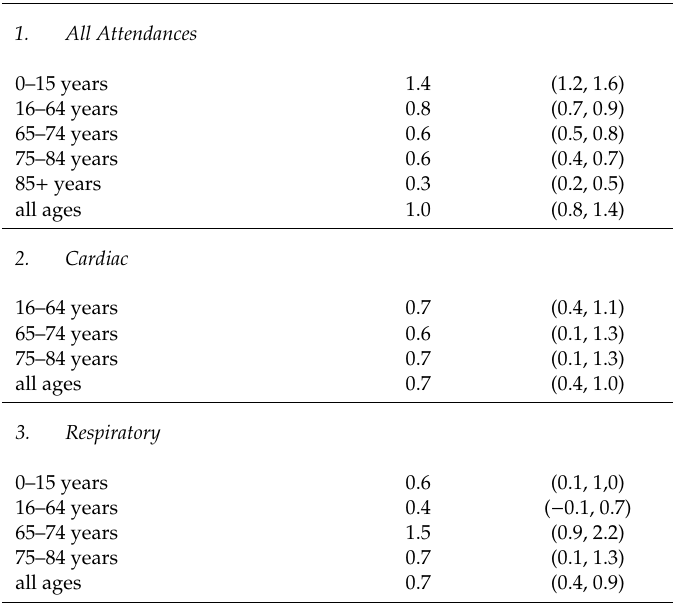
Table 2. Summary of main findings from the regression model investigating the heat e ff ect by cause and by age. Results shown are for the total e ff ect lagged over 0–2